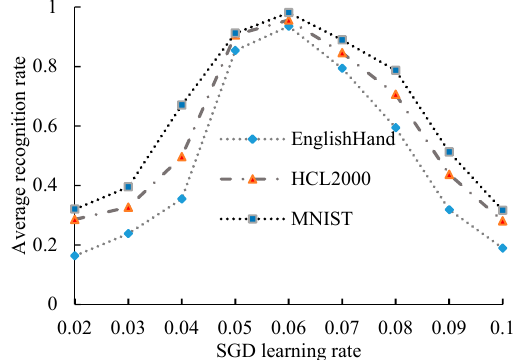
Figure 8. Recognition value under different stochastic gradient descent (SGD) learning rates.